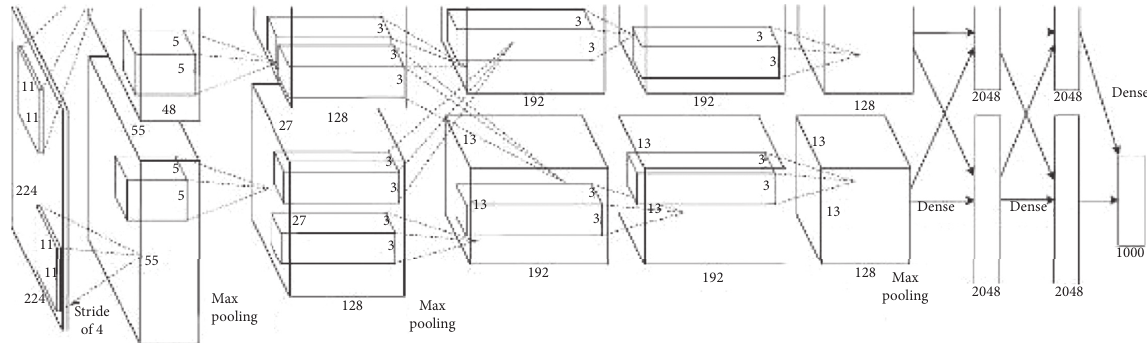
Figure 2: The network structure of traditional Alexnet.